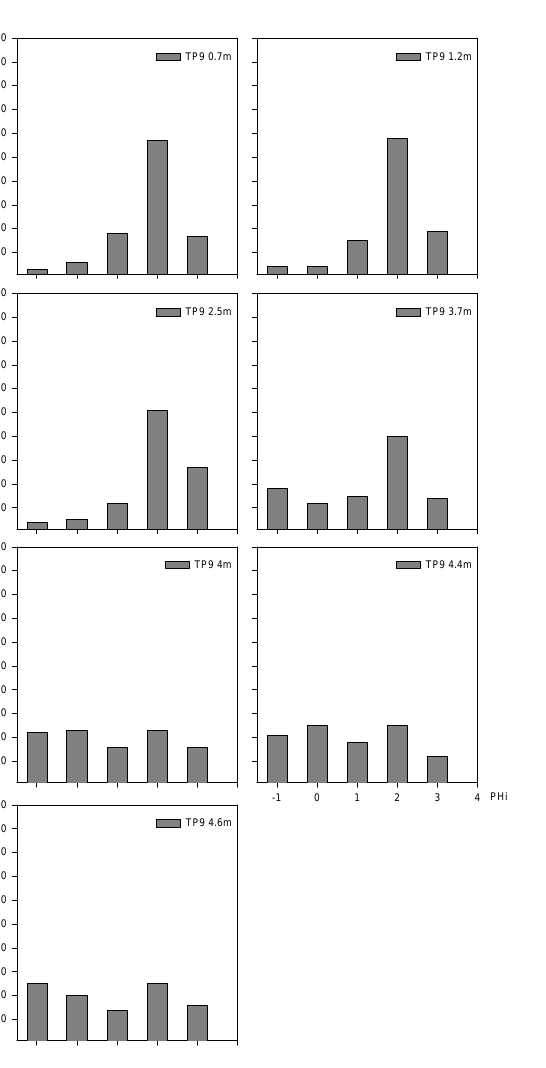
Figure 5. Distribution of five sand fractions of samples taken from the middle of the transition between the sandy material and the red clayey deposit that overlies the Irati formation (Tp9).